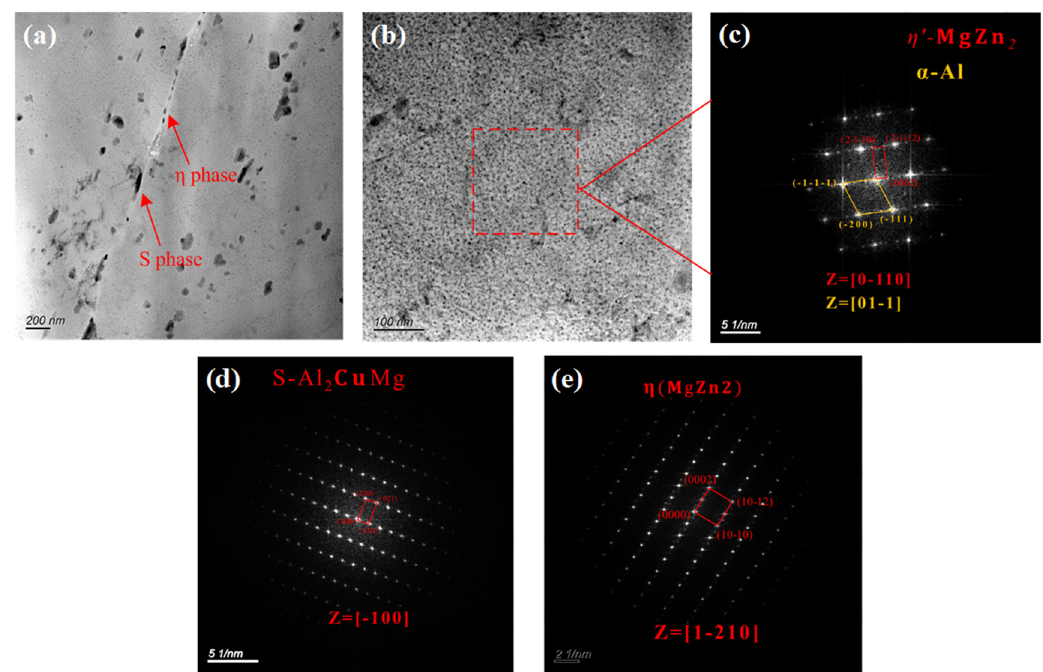
Figure 6. TEM images of the secondary phases of the 7075 alloy: ( a ) bright-field image of the grain boundary; ( b ) bright-field image of the grain interior; ( c ) diffraction spots of the secondary phase in the grain; ( d ) diffraction spots of S phase along the grain boundary; and ( e ) diffraction spots of η phase along the grain boundary.